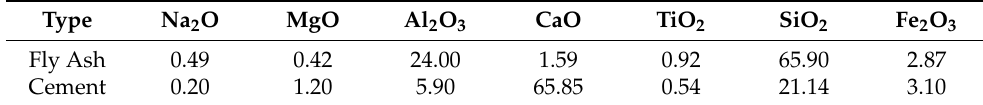
Table 1. Chemical Composition of Cement and Fly Ash